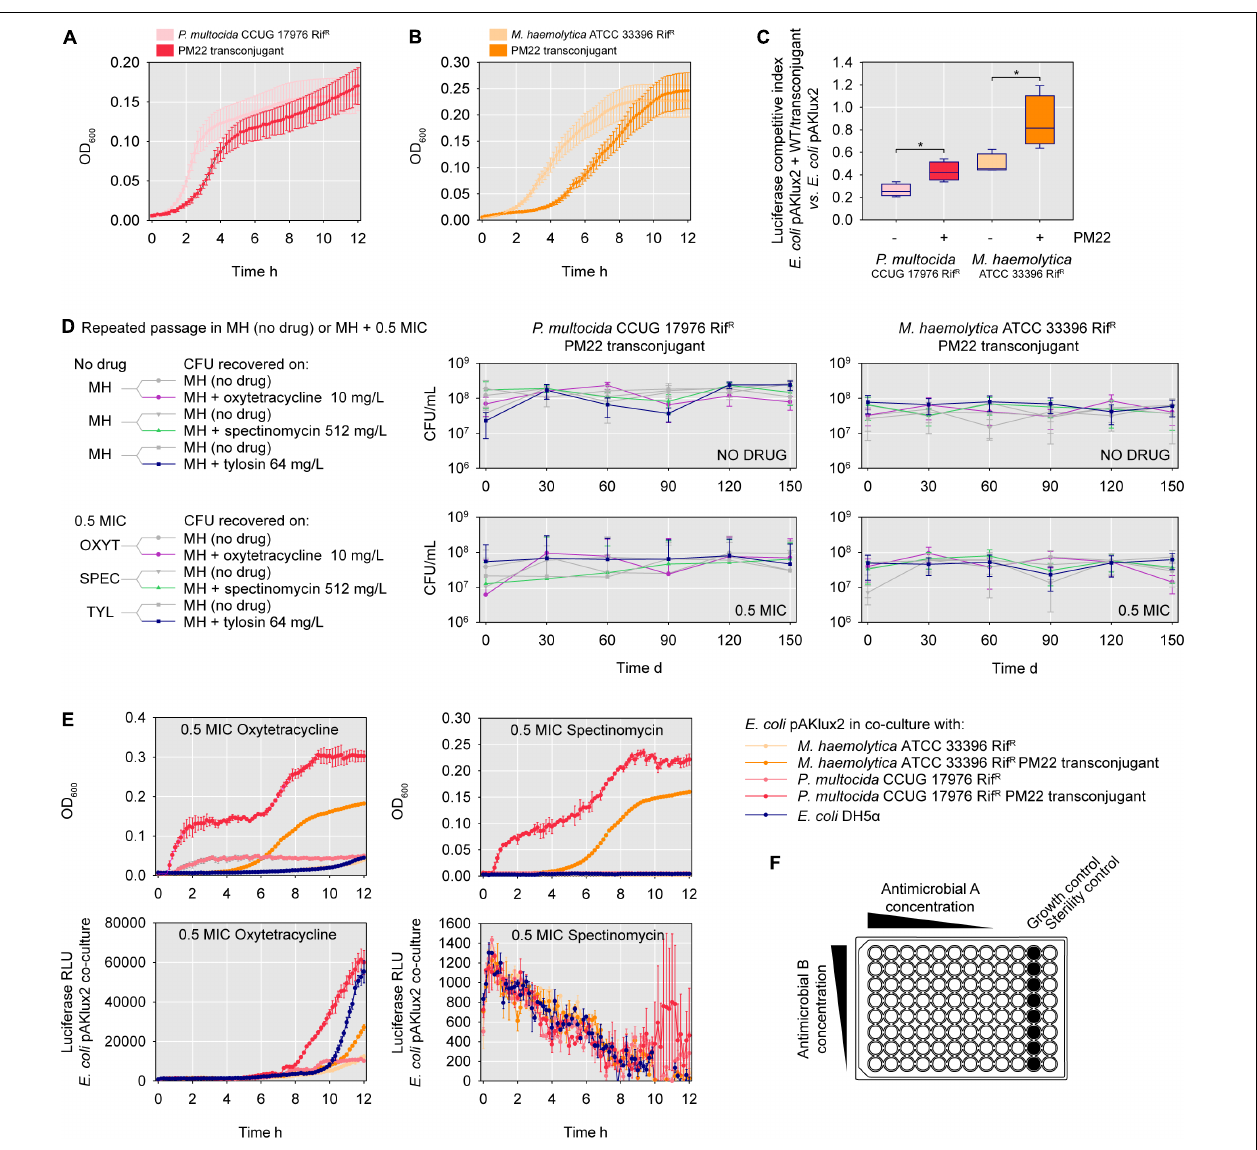
FIGURE 3 | ICE Mh1 PM22 fitness costs, addiction, and consequences for antimicrobial resistance in transconjugants. (A) Growth curves of P. multocida CCUG 17976 (spontaneous rifampin-resistant mutant) and isogenic ICE Mh1 PM22 transconjugant. Mean of 4 biological replicates with SEM. (B) Growth curves of M. haemolytica ATCC 33396 (spontaneous rifampin-resistant mutant) and isogenic ICE Mh1 PM22 transconjugant. Mean of 4 biological replicates with SEM. (C) Luciferase-based competition index from co-cultures of ICE Mh1 PM22 transconjugants and E. coli DH5 α harboring the luciferase expression plasmid pAKlux2. Mean of 4 biological replicates with SEM; t-test, ∗ P ≤ 0.05. (D) Long-term repeated passage of ICE Mh1 PM22 transconjugants. Transconjugants were grown in MH (no drug) or MH + 0.5 MIC (subinhibitory; MIC for susceptible P. multocida CCUG 17976 or M. haemolytica ATCC 33396 WT) for 150 days and plated on media with or without selective concentrations of indicated antimicrobials (i.e., 0.5 MIC for non-susceptible isogenic transconjugants). Mean of 3 biological replicates with SEM. (E) Upper panel: growth curves of co-cultures of E. coli DH5 α pAKlux2 and E. coli DH5 α , P. multocida CCUG 17976 ICE Mh1 PM22 , or M. haemolytica ATCC 33396 ICE Mh1 PM22 in subinhibitory (0.5 MIC for susceptible P. multocida CCUG 17976 or M. haemolytica ATCC 33396) concentrations of oxytetracycline (left) or spectinomycin (right). Mean of 3 biological replicates with SEM. Lower panel: detection of E. coli luciferase production in co-cultures (as above) with either oxytetracycline (left) or spectinomycin (right). (F) Schematic of checkerboard synergy assay for drug interaction screening.